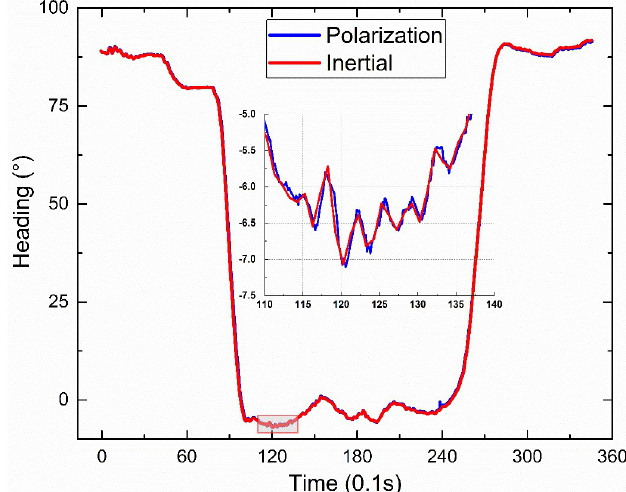
Figure 28. Headings of the polarization sensor and the inertial navigation system.